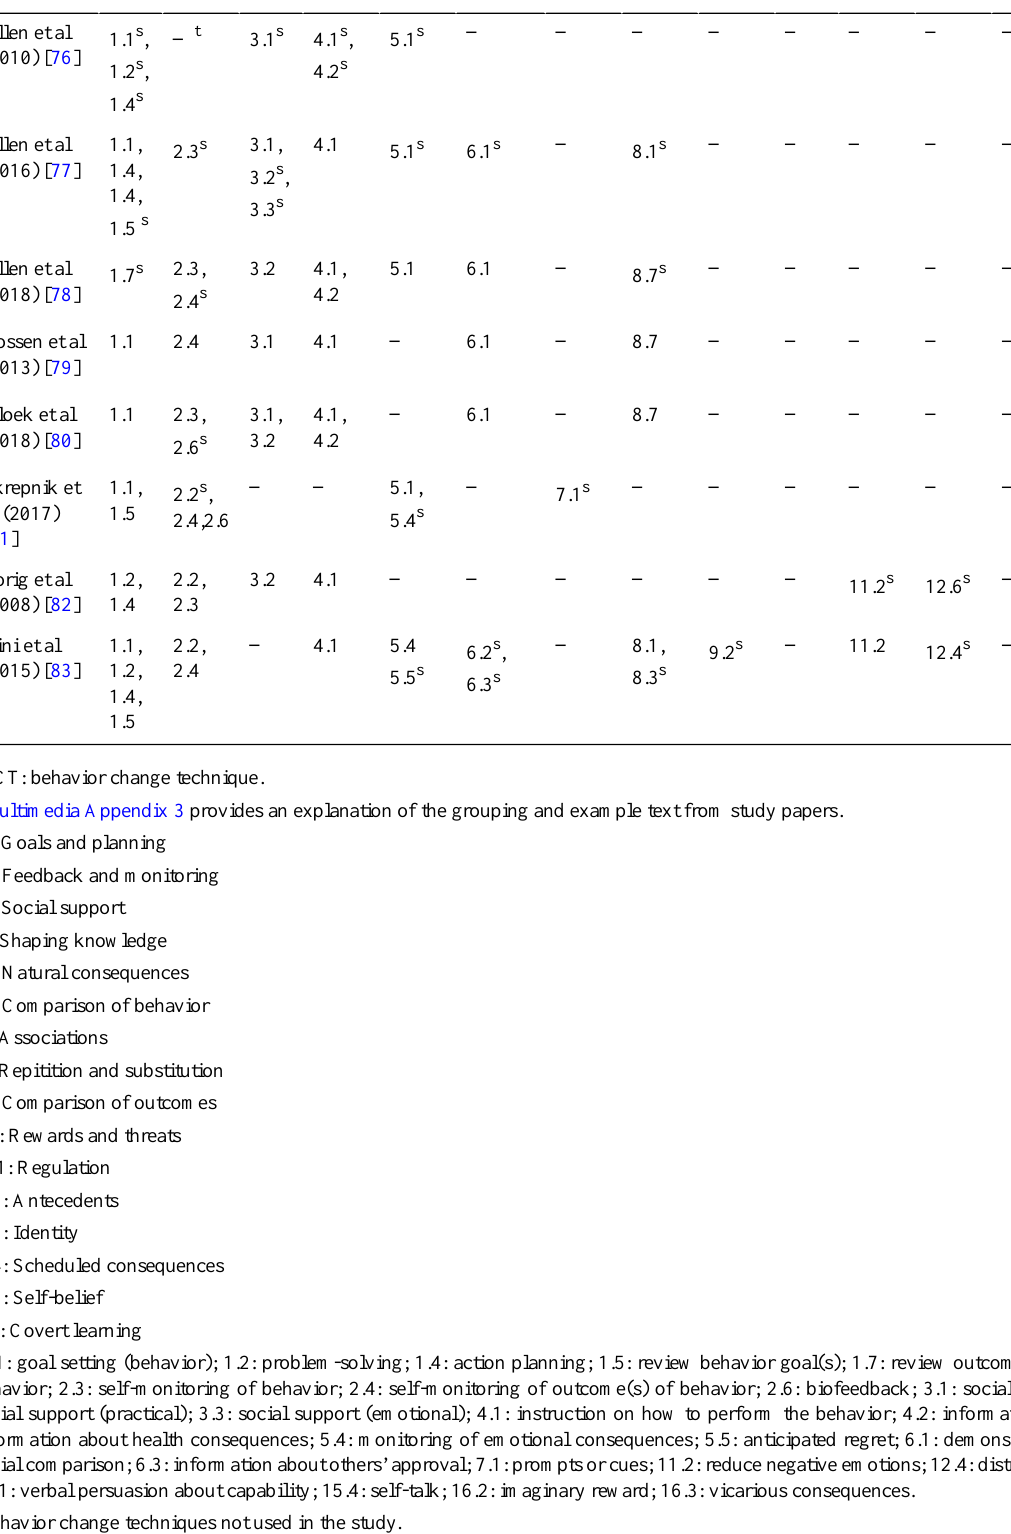
Table 6. Behavior change techniques used within included studies. BCT a taxonomy grouping b Author